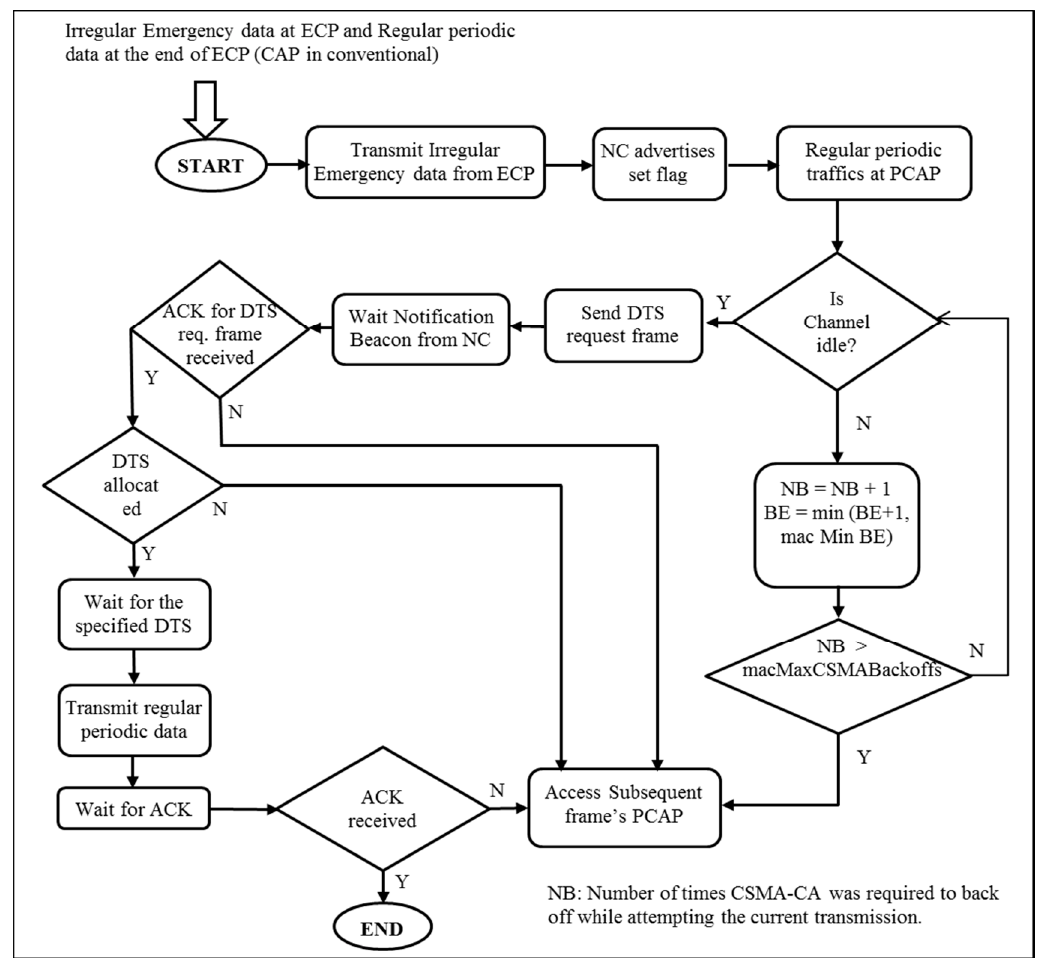
Figure 3. Flow Diagram of proposed scheme.